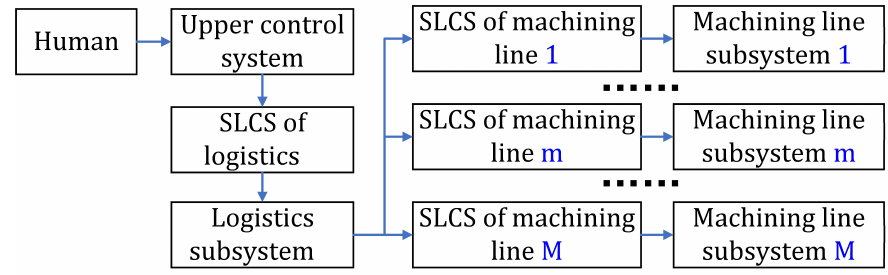
Figure 3. Reliability logic relation of SSL indices of a